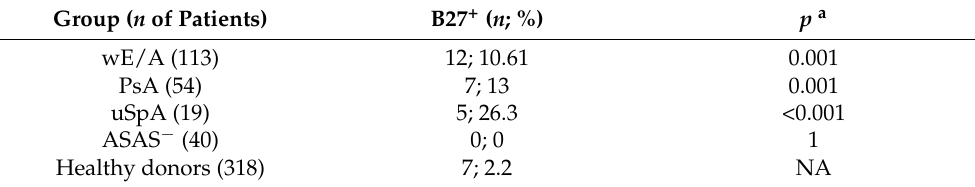
Table 2. Fisher’s exact test to define clinical characteristics showing a statistically higher (odds ratio; OR > 1) or lower (OR < 1) prevalence in peripheral seronegative enthesitis/arthritis (E/A) ASAS + (PsA and uSpA) vs. ASAS − clinical subgroups. Variable PsA vs. uSpA PsA vs. ASAS − uSpA vs. ASAS − p ; OR a Female 0.745; 0.6 0.607; 0.7 1; 1.06 Age 0.355 0.329 0.221 Age at the onset of first symptoms 0.580 0.03 0.09 Weight 0.554 0.880 0.662 Height 0.465 0.058 0.425 BMI 0.811 BMI > 29.9 1; 0.88 0.817; 0.89 1; 1.06 Familiarity for psoriasis <0.001; 13.86 <0.001; 33.8 0.072; 0.83 Cutaneous psoriasis <0.001; NA <0.001; NA NA Peripheral and axial arthritis 0.69; 0.66 0.132; 5.12 0.094; 0.13 Smoking 0.098; 0.31 0.216; 0.52 0.366; 0.56 Hypertension 0.033; 3.75 0.214; 1.80 0.247; 2.25 Cardiovascular risk 0.41; 1.78 0.275; 1.79 1; 1.06 Metabolic syndrome 0.276; 0.32 1; 1.57 0.240; 0.21 Autoimmune thyroiditis 0.72; 1.93 0.256; 2.15 1; 0.94 Fibromyalgia 1; 1.07 0.80; 1.21 1; 0.93 Malignancy 0.67; 2.25 0.727; 1.62 1; 1.45